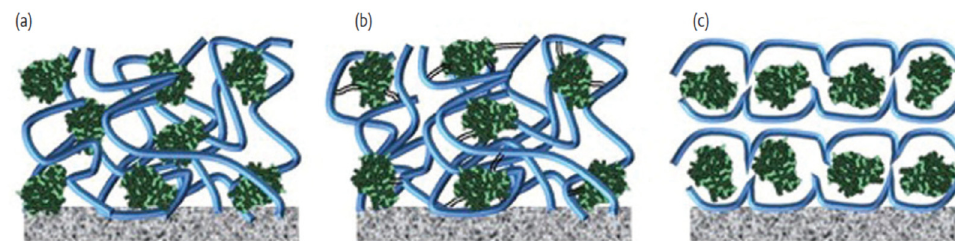
Figure 1. Enzymes immobilized on an electrode surface via ( a ) physical adsorption to a polymer, ( b ) covalent attachment to a polymer (as shown by the black and white tethers), or ( c ) encapsulation in [35]. Copyright 2012 Elsevier.